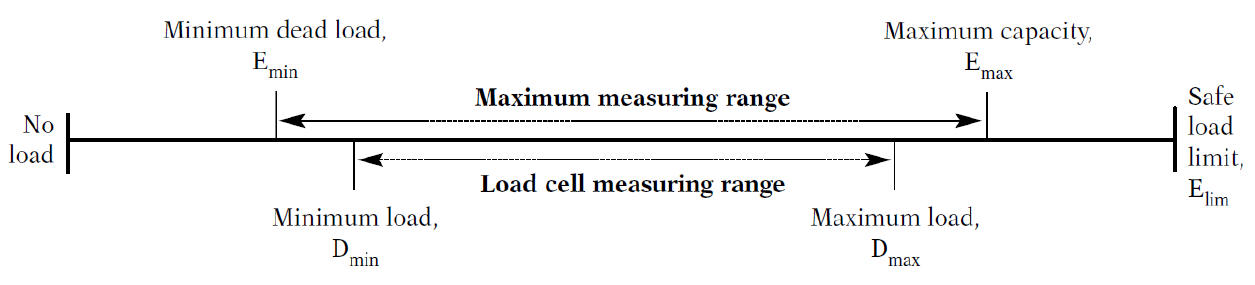
Figure 1. Graphical representation of the defined